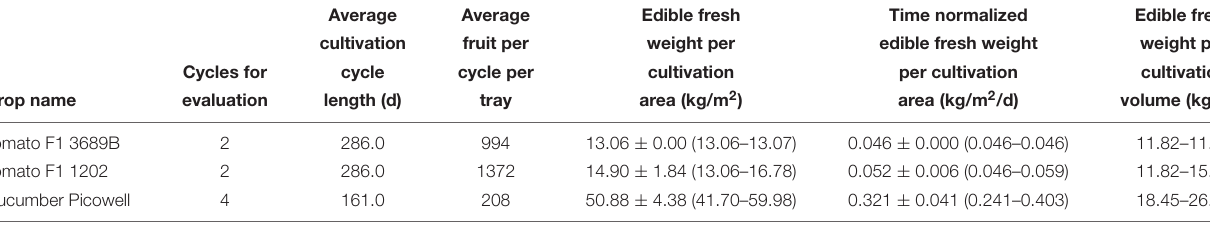
TABLE 8 | Fruit crops edible fresh weight production values.